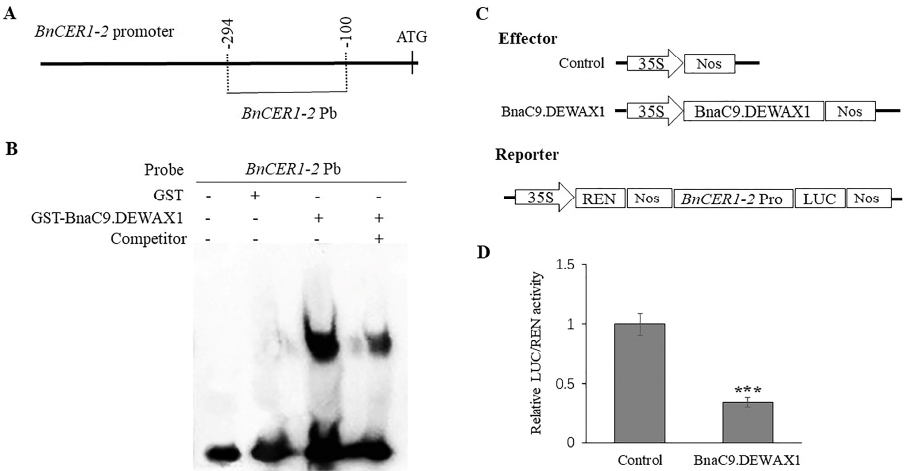
Figure 2. BnaC9.DEWAX1 binds to BnCER1-2 promoter and acts as a transcriptional repressor. ( A ) Diagram of the BnCER1-2 promoter fragment used for EMSA. The position of the promoter fragment relative to the start codon is shown above the line. ( B ) EMSA of BnaC9.DEWAX1 binding to the promoter sequence of BnCER1-2 gene. Labeled DNA fragment (50 µ M) incubated with 6 µ g of recombinant GST-BnaC9.DEWAX1 protein was assayed. GST was used as a control protein. For competition analysis, excess unlabeled DNA fragments relative to the labeled probes were included in the reactions. ( C ) Diagram of reporter and effector constructs used for transactivation analysis. ( D ) BnaC9.DEWAX1 transcriptionally repressed BnCER1-2 promoter-driven expression of LUC re- porter gene. The reporter and effector construct were co-transfected into Arabidopsis leaf protoplasts. LUC activity was measured and normalized based on the level of REN activity. Error bars represent SD of three biological replicates. Data were statistically analyzed using Student’s t test (*** p < 0.001).